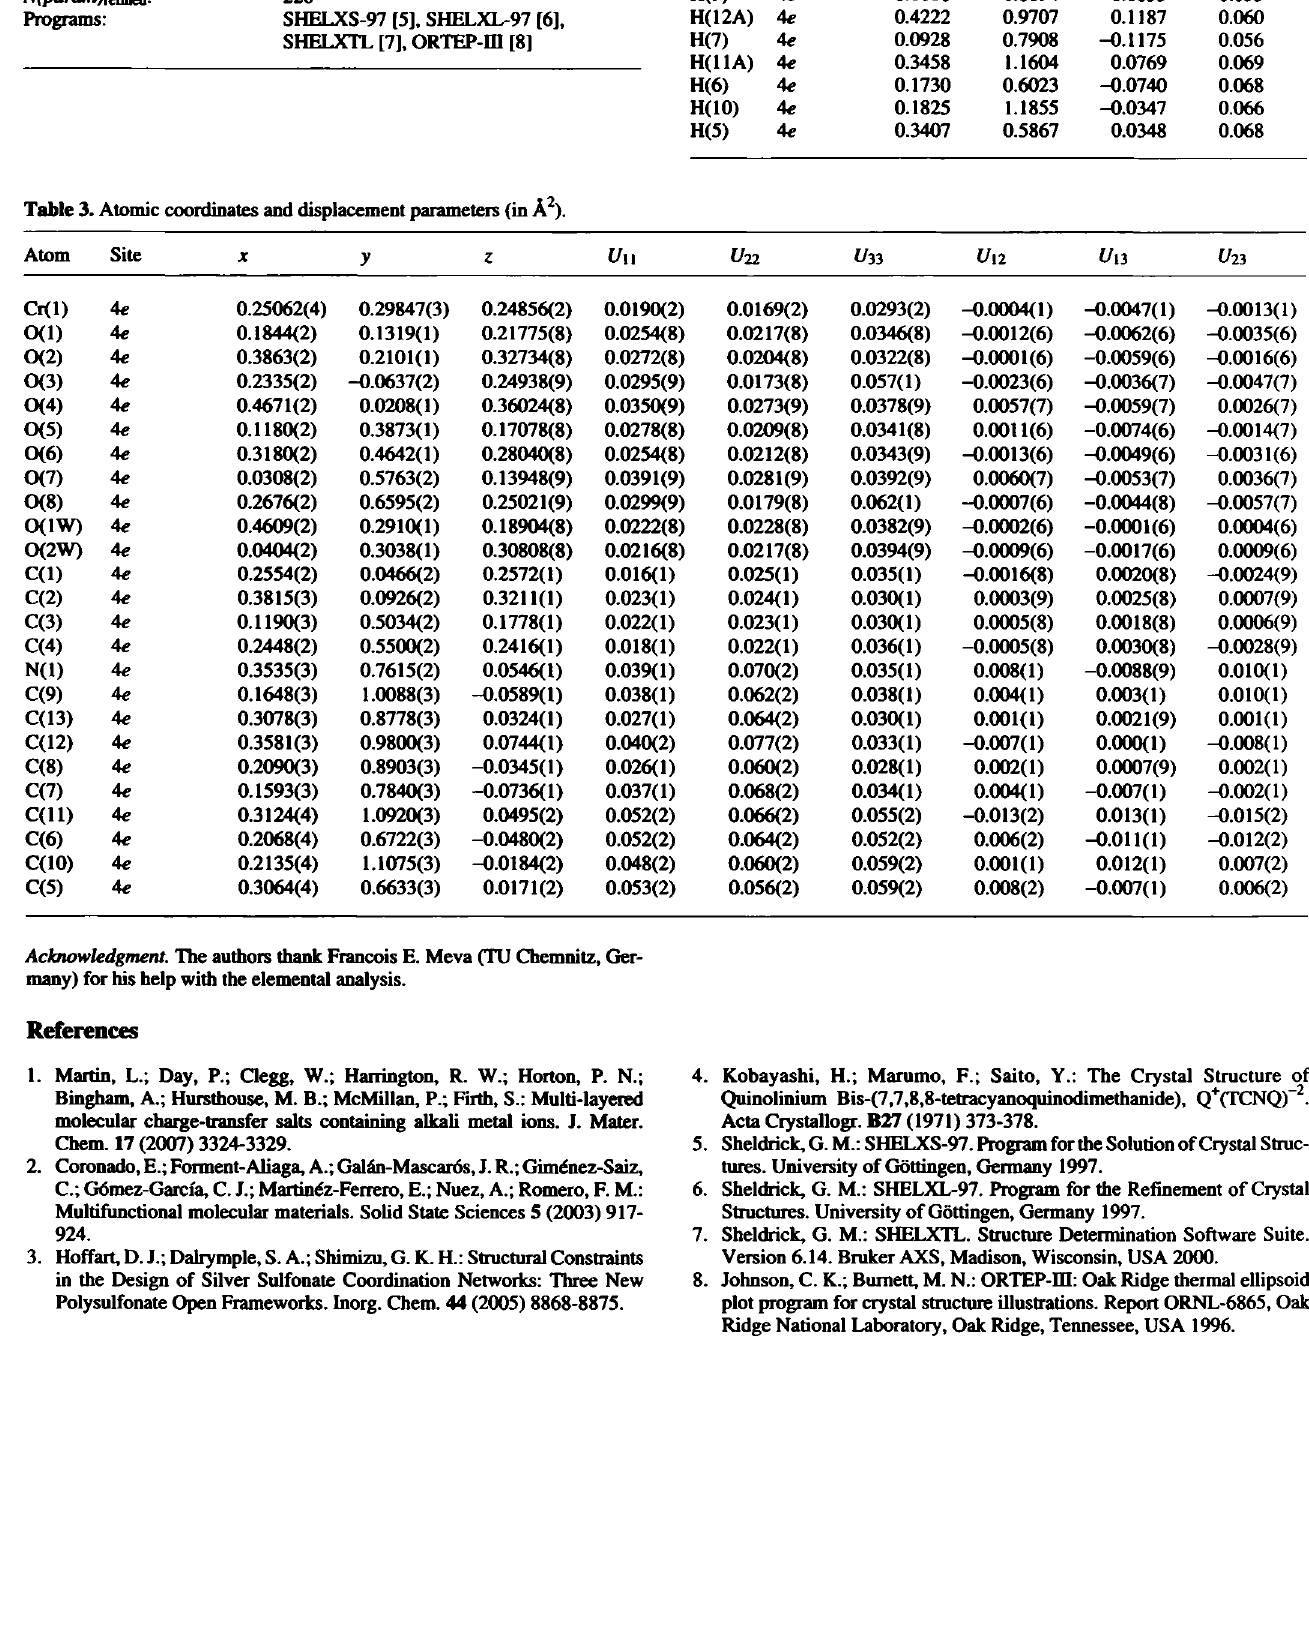
Table 3. Atomic coordinates and displacement parameters (in À 2